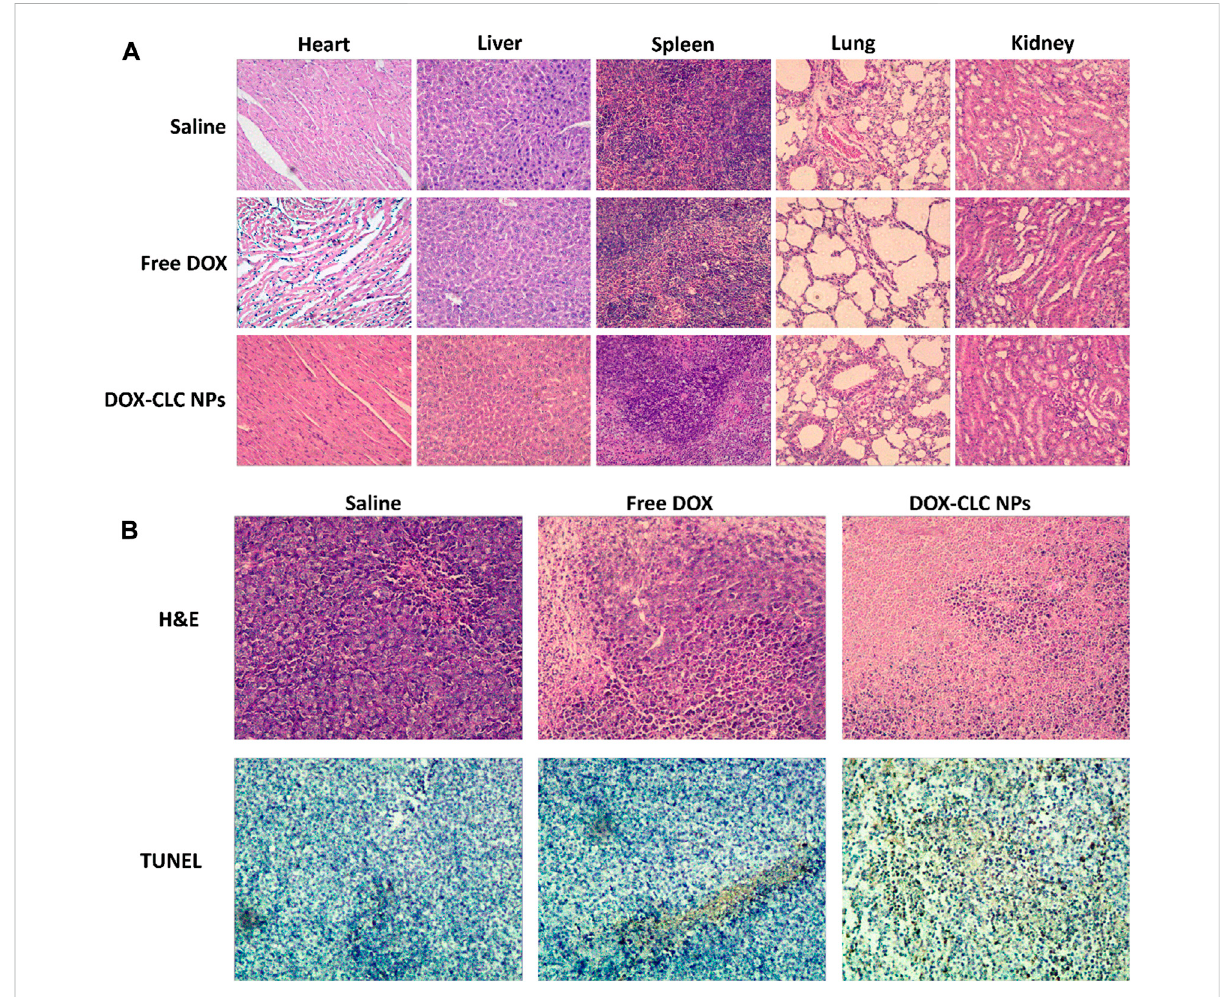
FIGURE 9 Histopathological analysis of heart, liver, spleen, lung, and kidney sections stained with H&E at day 14 (A) ; H&E and TUNEL analysis of tumor at day 14 (B) ; Images were obtained under an inverted microscope using a ×20 objective.